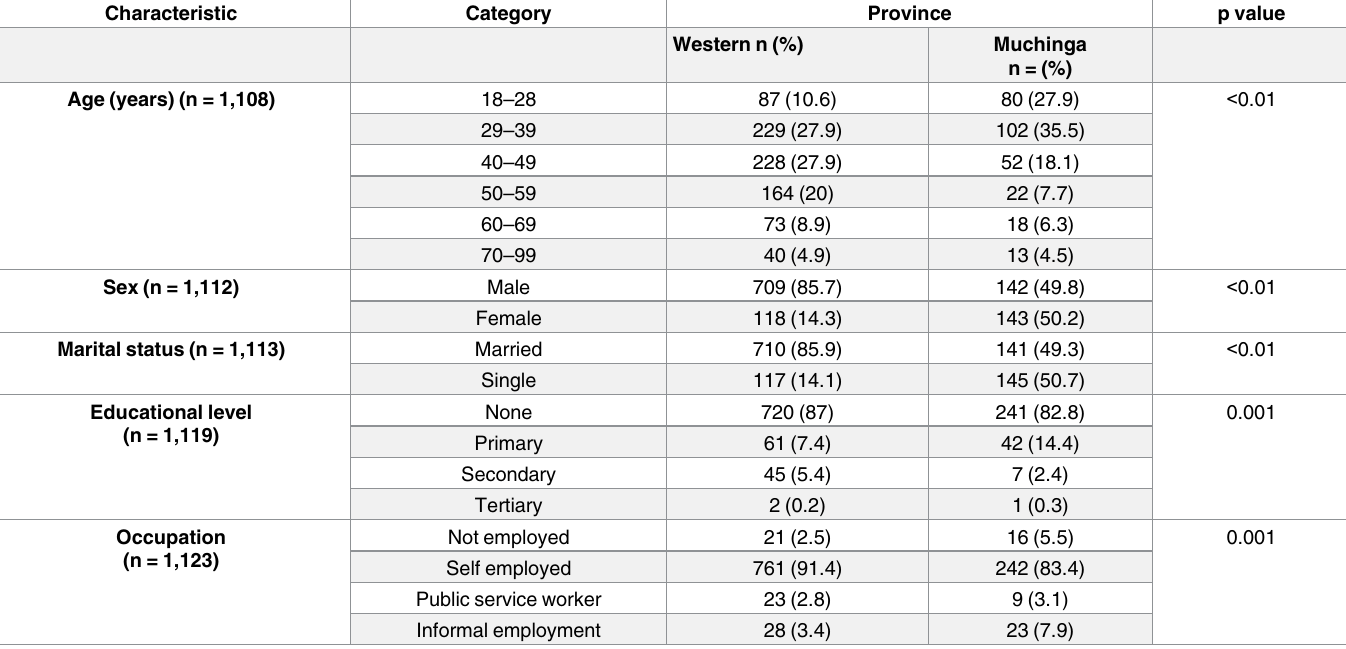
Table 1. Comparison of socio-demographic characteristics of respondents between Western and Muchinga provinces.